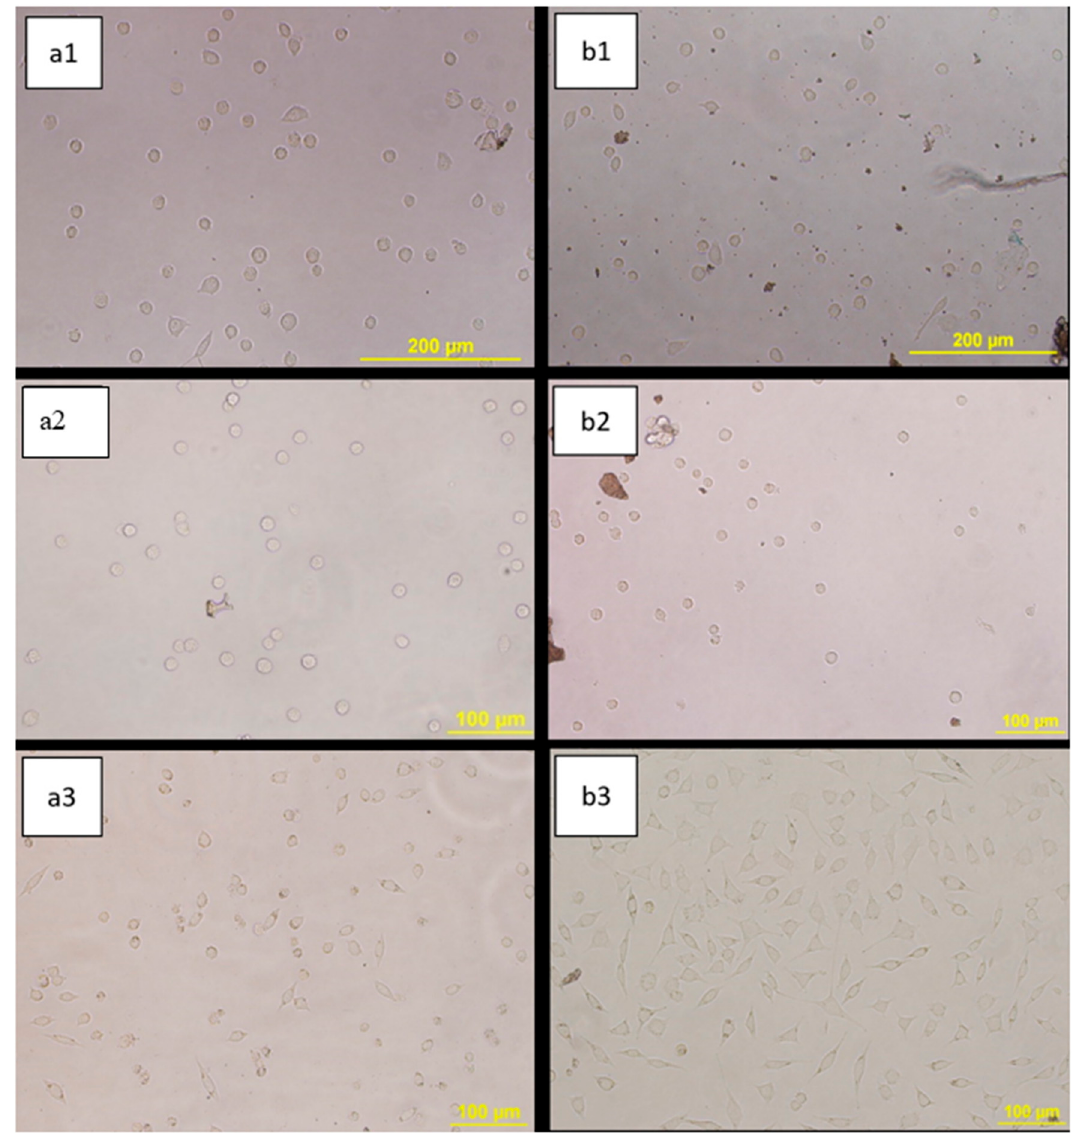
Figure 12. Optical micrographs. ( a1 ) L-929 in 0-HA at 0 h; ( a2 ) L-929 in 0-HA at 24 h; ( a3 ) L-929 in 0-HA at 48 h; ( b1 ) L-929 in 5-HA HIPEs at 0 h; ( b2 ) L-929 in 5-HA HIPEs at 24 h; ( b3 ) L-929 in 5-HA HIPEs at 48 h.